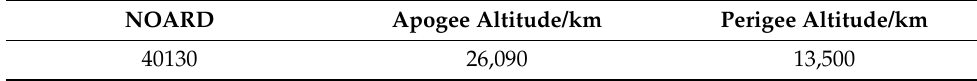
Table 2. Orbital parameters of the upper stage numbered 40130 [22].